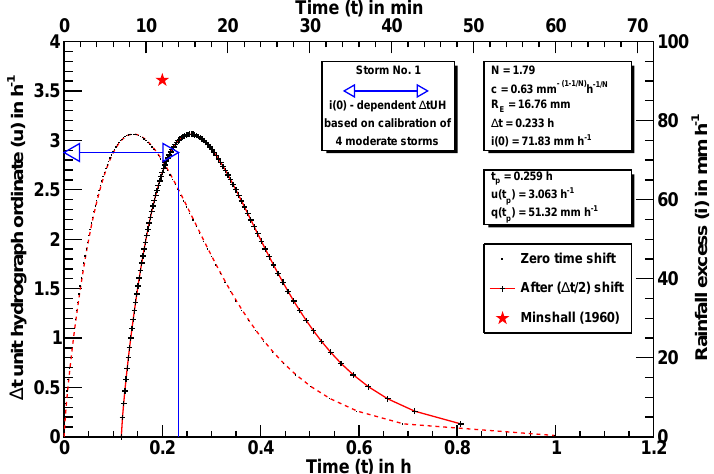
Fig. 7a. Prediction of the 1t unit hydrograph for the largest storm, storm no. 1, on the Edwardsville, Illinois, watershed, using the calibrated variable IUH model parameters for four moderate storms, storm nos. 2–5, and by the direct Bakhmeteff function method of convolution. For comparison, the peak characteristics reported by Minshall (1960) are shown as a red star.